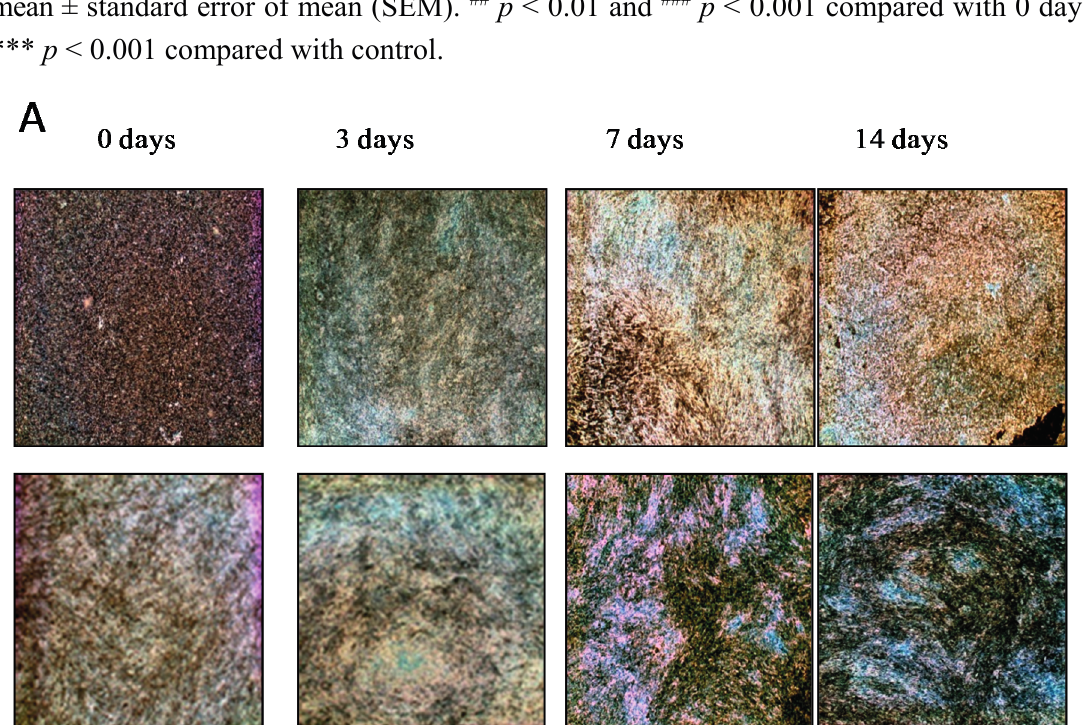
Figure 2. Effects of mangiferin on chondrogenic differentiation in mesenchymal stem